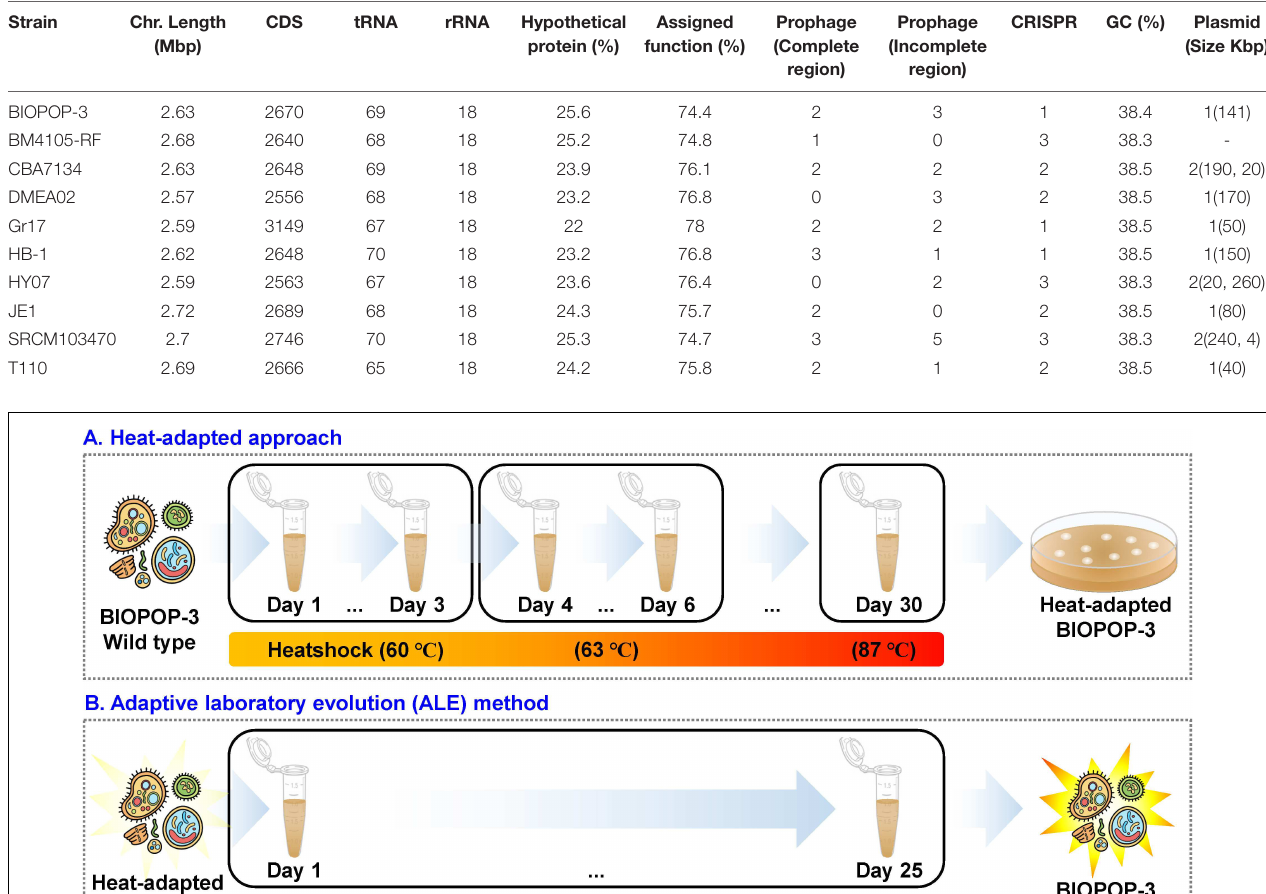
TABLE 1 | Features of E. faecium strains close to BIOPOP-3.